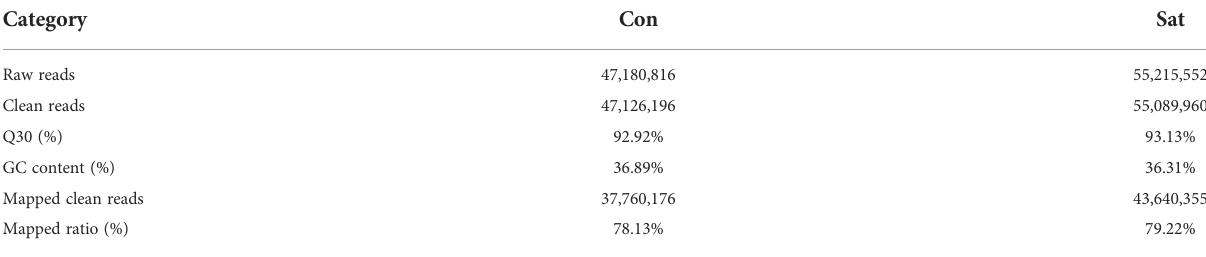
TABLE 2 Summary of sequencing results.